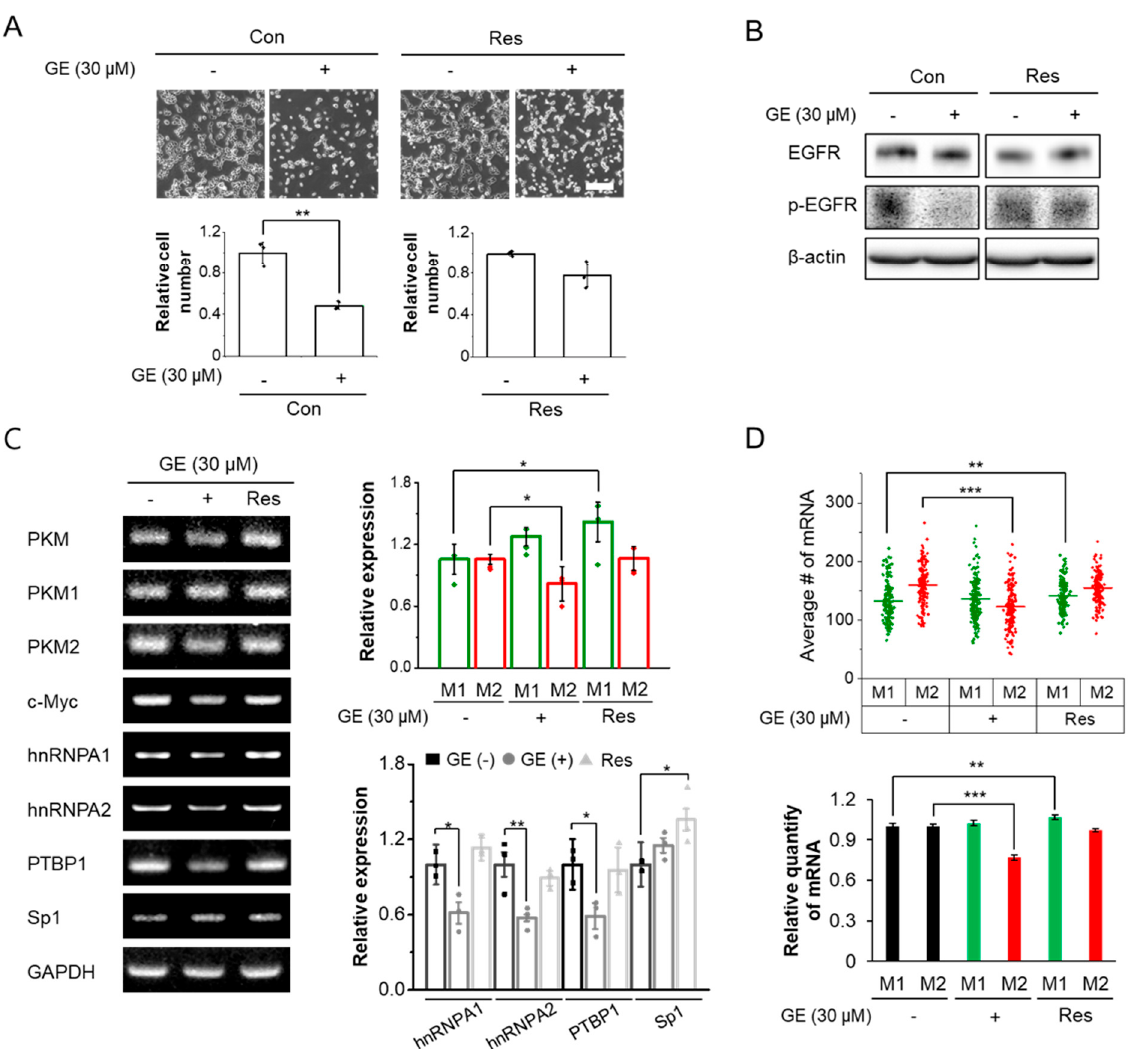
Figure 3. Effects of GE on the mRNA levels of PKM isoforms and proteins involved in PKM regulation. Cells were untreated ( − ) or GE-treated for 24 h (+). GE-resistant cells (GE Res) were also analyzed. ( A ) Evaluation of the cell viability. HCT116 cells (Con) or GE-resistant HCT116 cells (Res) were cultured in the absence or presence of 30 µ M GE for 24 h, and viable cells were counted as described in the Materials and Methods section. Data are shown as average ± SD of three independent experiments. Scale bar, 200 µ m. ( B ) The effect of GE on cell viability. HCT116 cells (Con) or GE-resistant HCT116 cells (Res) were treated with 30 µ M GE for 24 h; then, the degree of EGFR expression and activation was measured by Western blotting. Untreated cells were used as a negative control. ( C ) RT-PCR analysis for PKM isoforms, c-Myc, hnRNPs, PTBP1, and Sp1. M1 and M2 in the graph correspond to PKM1 and PKM2, respectively. ( D ) Quantitative SM-FISH-STIC analysis of PKM isoforms. M1 and M2 correspond to PKM1 and PKM2, respectively. Error bars represent average ± SEM ( n ≥ 162). * p < 0.05, ** p < 0.01, and *** p < 0.001.